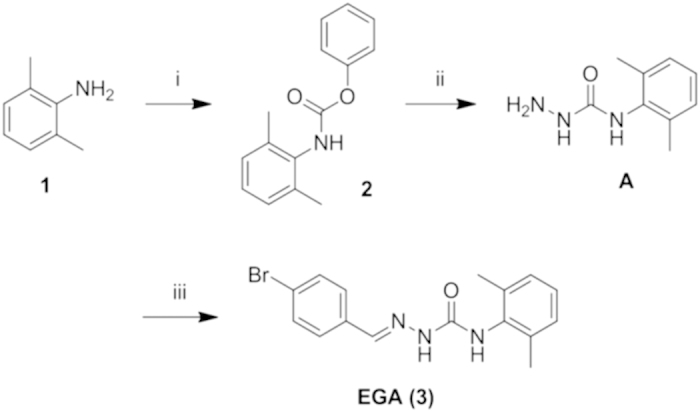
Synthesis of EGA.Synthesis of 2-(4-bromobenzylidene)-N-(2,6-dimethylphenyl)hydrazinecarboxamide (EGA); Reagents and conditions (i) ClCO2Ph, Py, DCM (96% isolated yield); (ii) NH2NH2·H2O, DME (iii) 4-bromobenzaldehyde, CHCl3 (88% isolated yield, passages ii and iii).